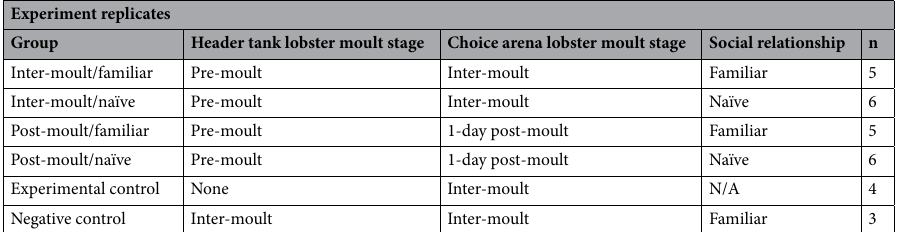
Negative Table 1. P. ornatus, tropical rock lobster, moult stages and social relationship in control and treatment replicates. n = number of replicates.